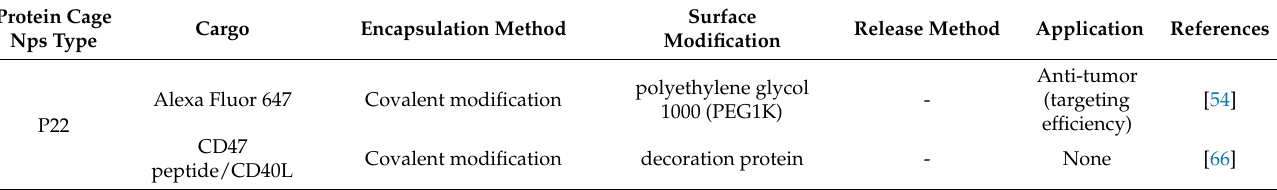
Table 2. Protein cage NPs for drug encapsulation and